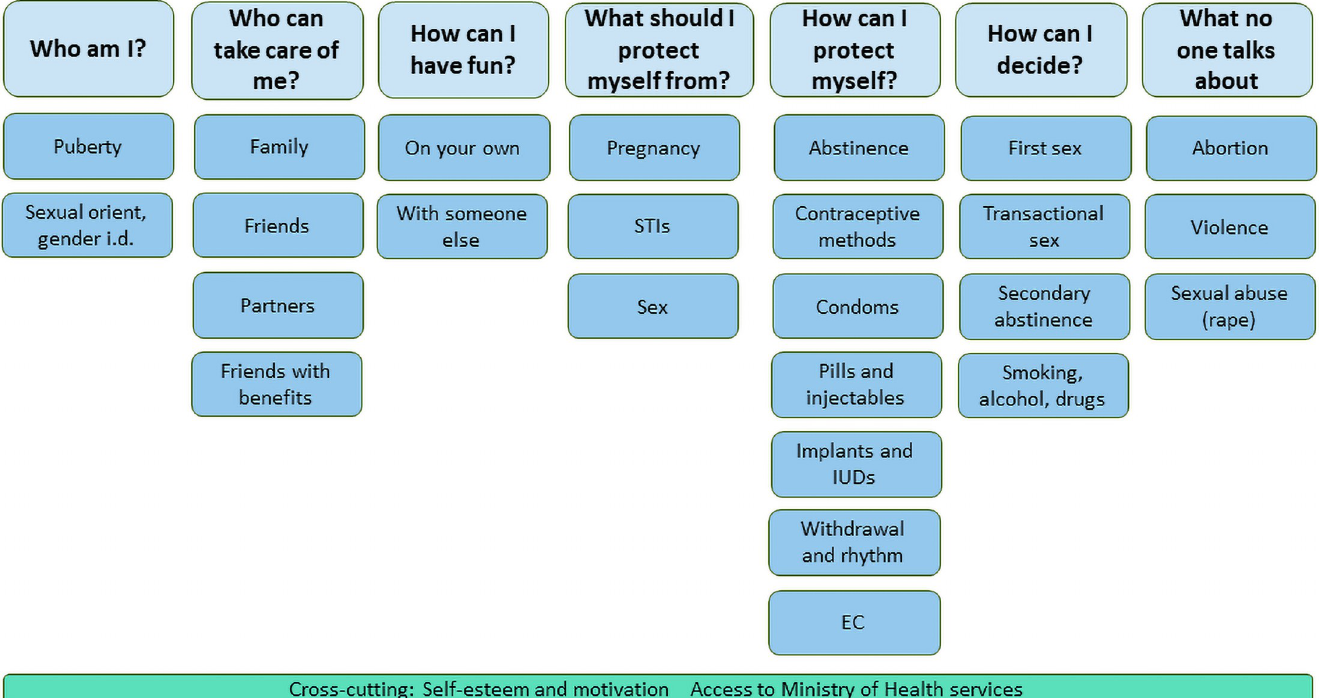
Fig 1. Domains and sub-domains for the ARMADILLO Peru SMS intervention.